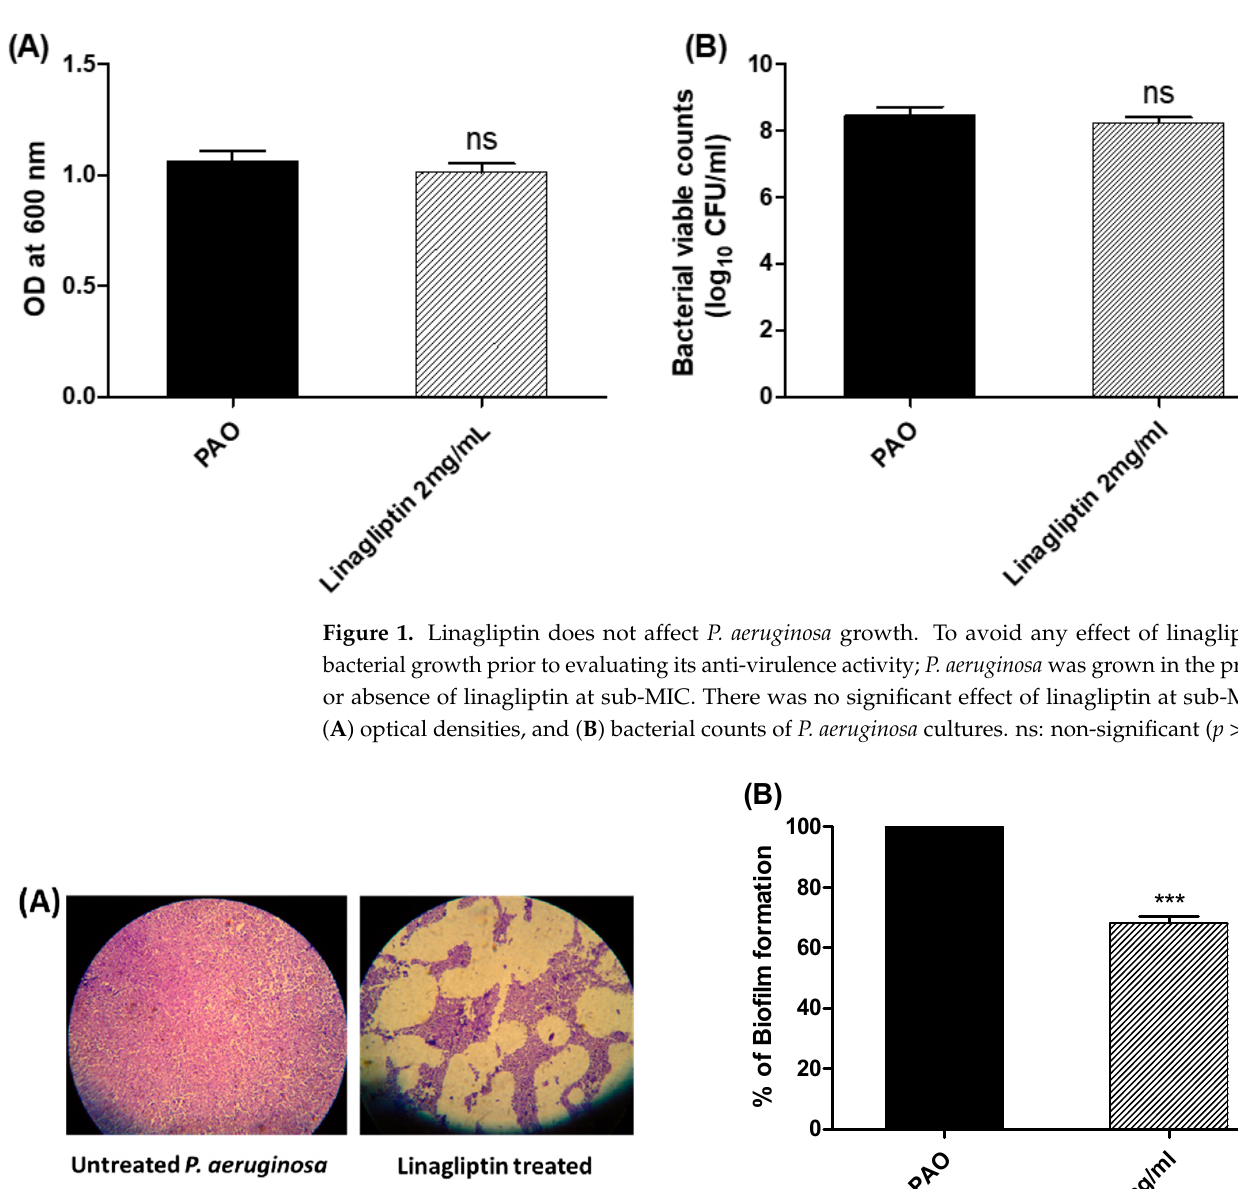
Figure 1. Linagliptin does not affect P. aeruginosa growth. To avoid any effect of linagliptin on bac- terial growth prior to evaluating its anti-virulence activity; P. aeruginosa was grown in the presence or absence of linagliptin at sub-MIC. There was no significant effect of linagliptin at sub-MIC on ( A ) optical densities, and ( B ) bacterial counts of P. aeruginosa cultures. ns: non-significant ( p > 0.05)